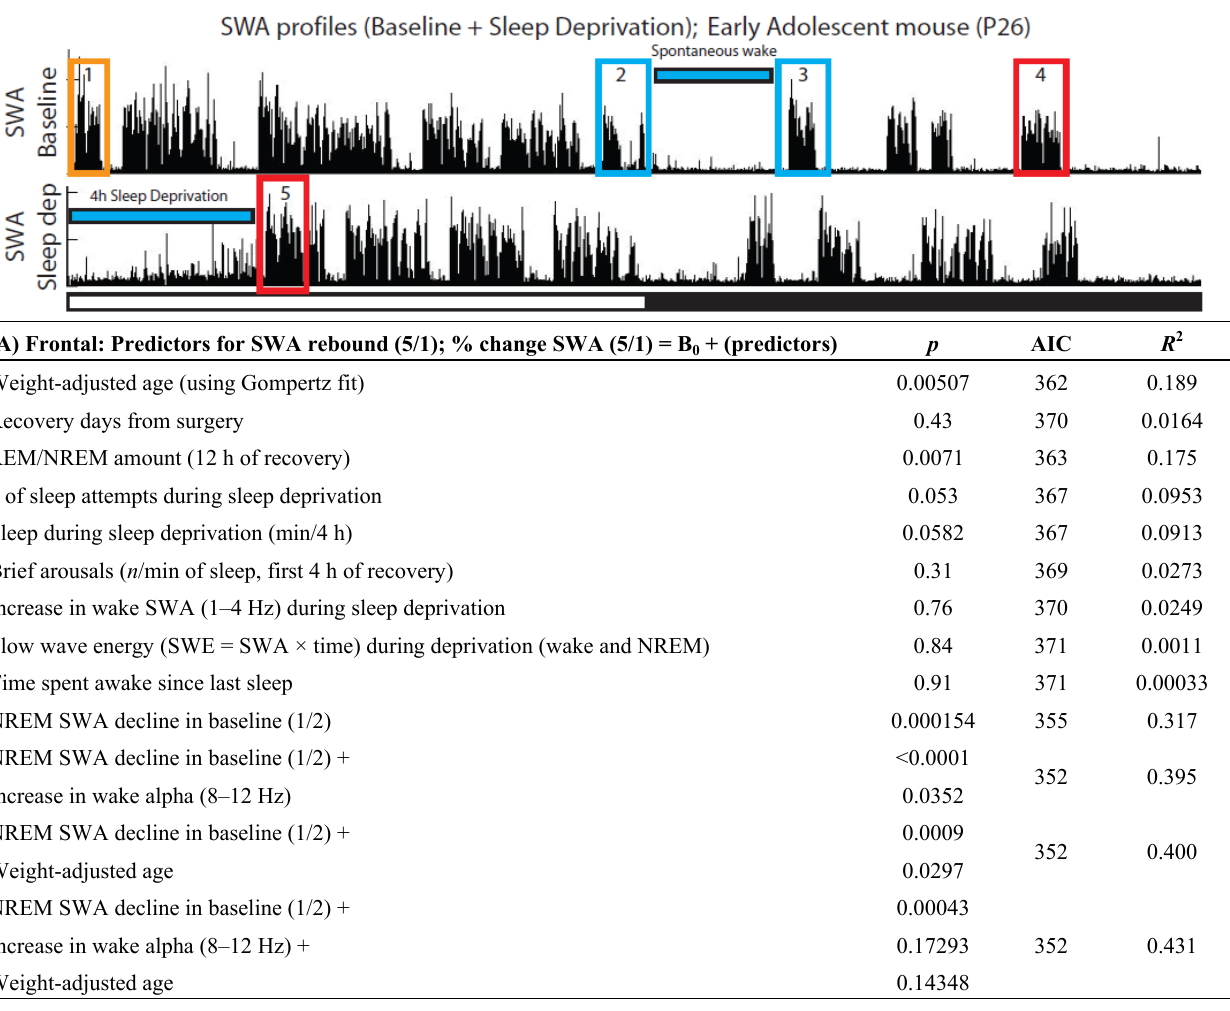
Table 2. Multiple predictor linear regression for the SWA rebound after sleep deprivation ( A , D ), the SWA changes from immediately before to after sleep deprivation ( B , E ), and the SWA changes during spontaneous periods of wake ( C , F ). A – C , frontal cortex; D – F , parietal cortex. The appropriateness of models to explain the variability in SWA changes was assessed using the Akaike’s information criteria (AIC). For models including multiple predictors, p -values indicate the probability that the corresponding parameter has predictive value when all other parameters are included. AIC and R 2 are given for each model; R 2 indicates the portion of variance explained by the model and will increase when additional variables are added to a model. AIC is a measure of the relative goodness of fit for a model. More adequately fitting models have lower AIC, but adding poor predictors will increase AIC (indicating a less appropriate model) even if the R 2